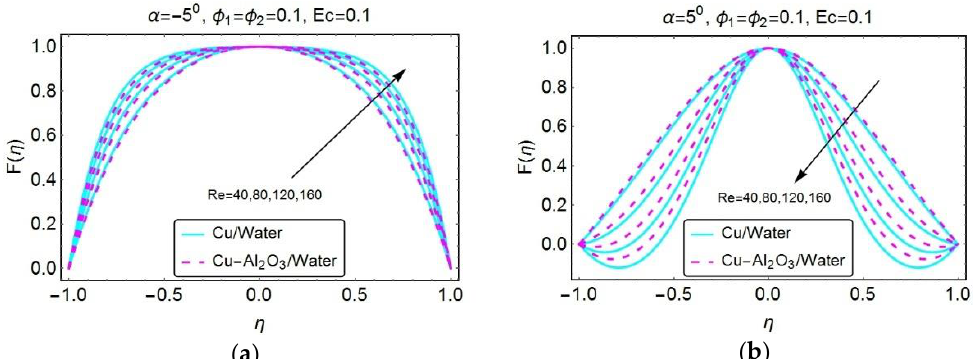
Figure 5. Stimulus of Re on F(η) : ( a ) convergent case and ( b ) divergent channel.